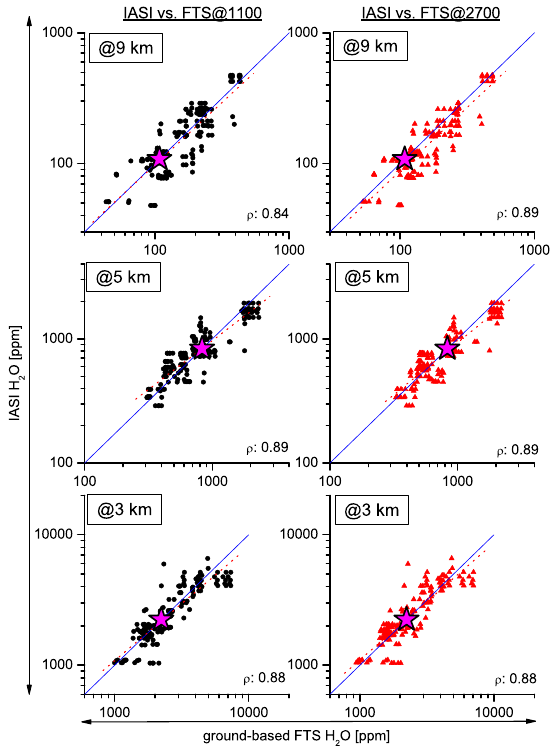
sensitive than the FTS system and consequently both data set are less comparable. Close to the altitude of Iza˜na the com- pletely missing sensitivity of the FTS for lower tropospheric H 2 O makes the two data set not comparable.